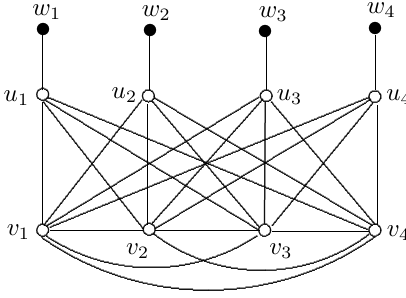
Figure 6: The graph G